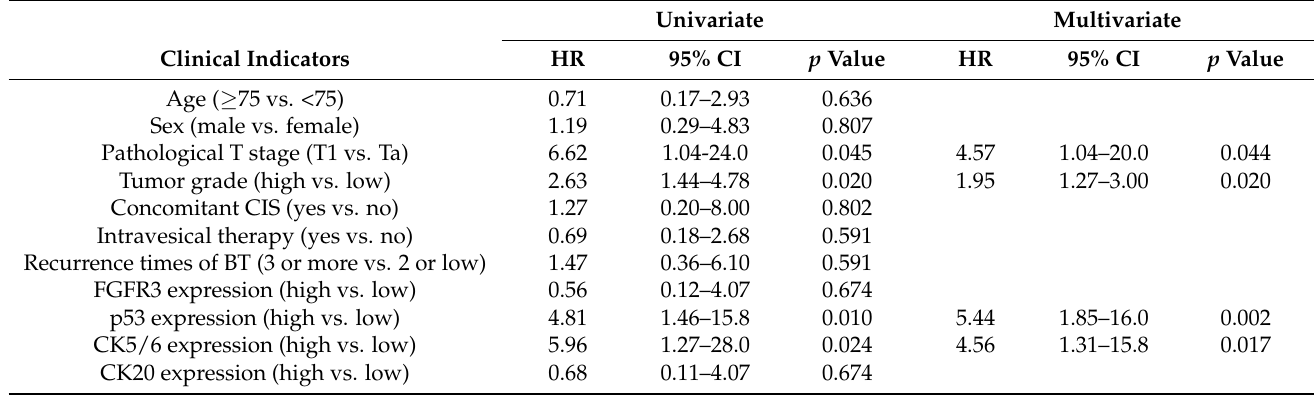
Table 4. Uni- and multivariate Cox regression analyses for determining risk factors for